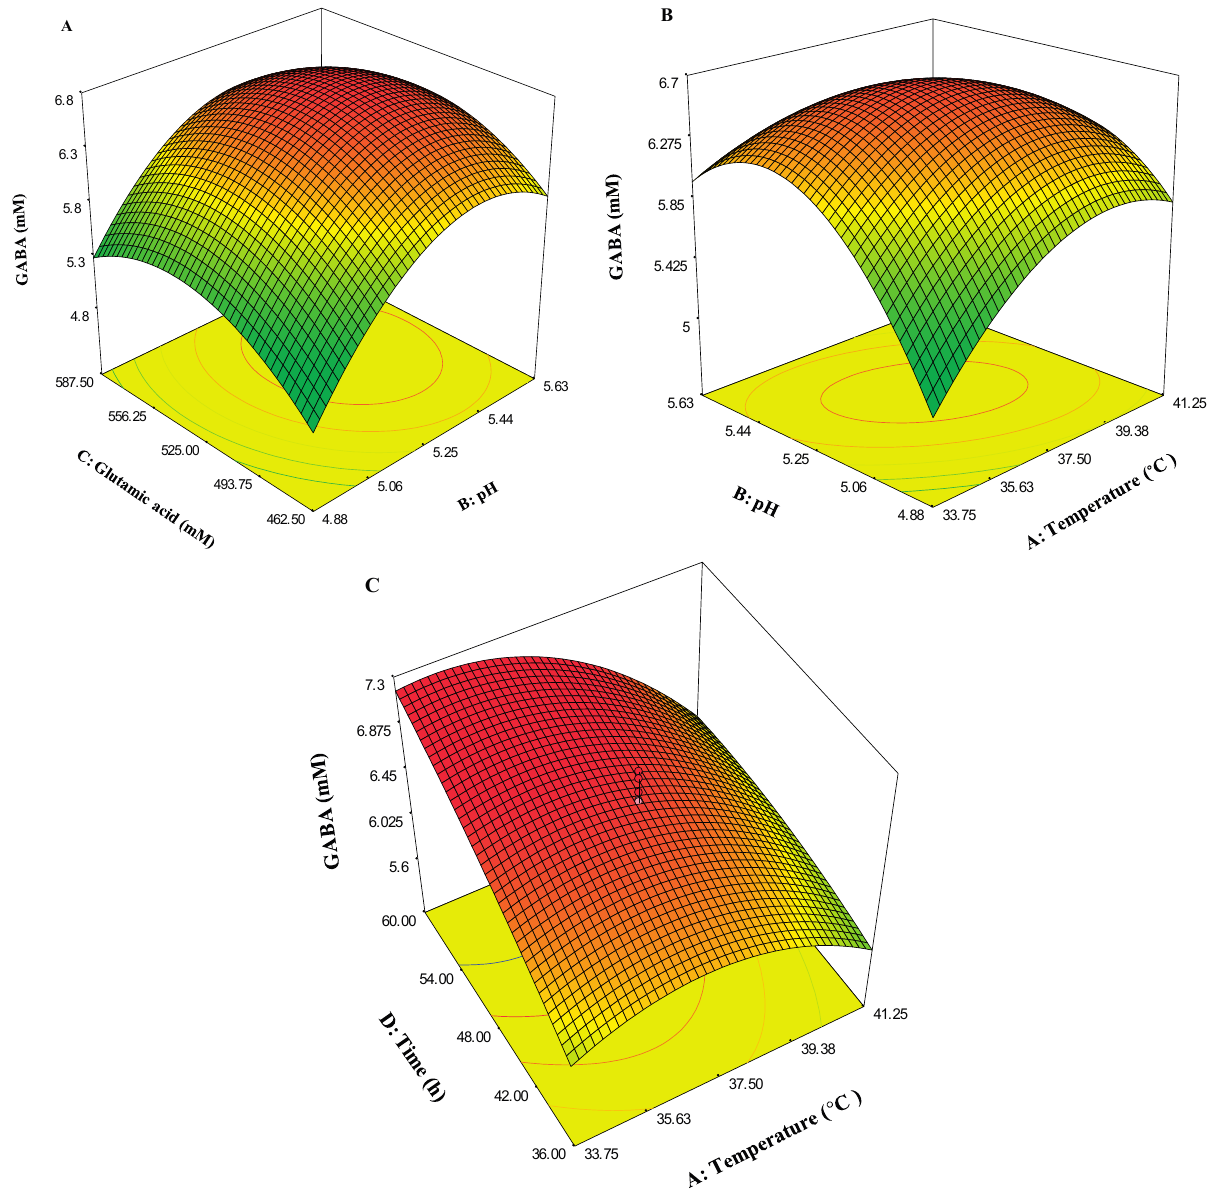
Figure 7. Three-dimensional surface plots showing the effect of different variables on GABA production. ( A ) Effect of initial glutamic acid and pH; ( B ) Effect of temperature and pH; ( C ) Effect of temperature and